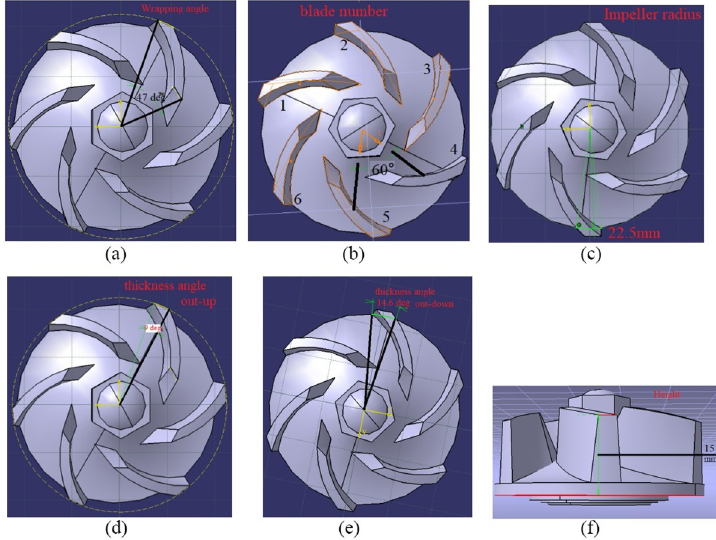
Fig 4. Parametric variables of impeller for hydraulic performance optimization: (a) wrapping angle; (b) blade number; (c) impeller radius; (d) thickness angle out-up; (e) thickness angle out-down; (f) impeller height.